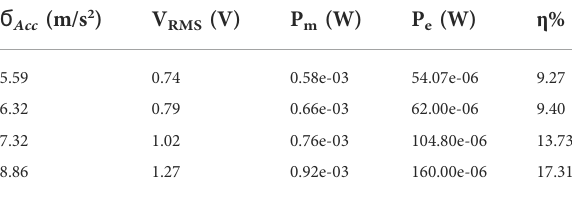
TABLE 4 The estimated ef fi ciency, η , the RMS acceleration, A RMS , and the electrical, P e , and mechanical, P m , powers for the harvester presented in [47], a) with and b) without the repulsive magnet ( © 2018